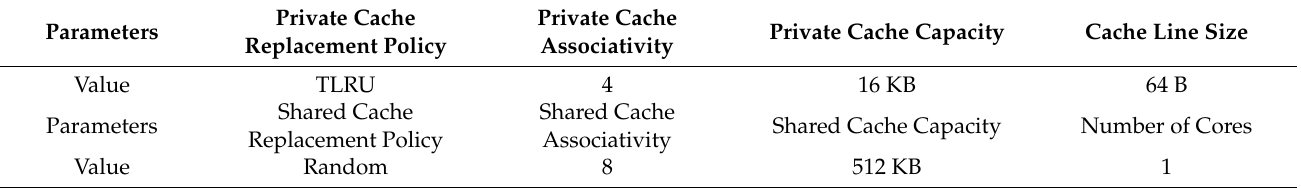
Table 3. Baseline